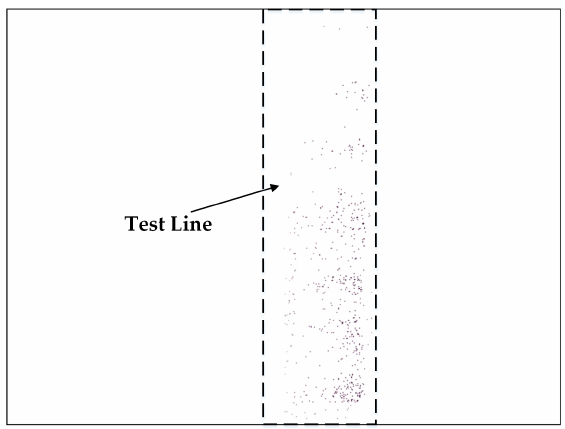
Figure 8. Valid points of the segmented image.